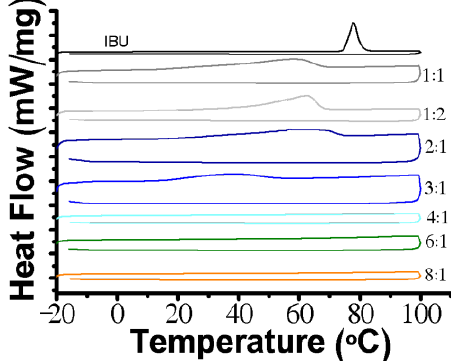
Figure 2. DSC thermogram of IBU and POH:IBU at different molar ratios.